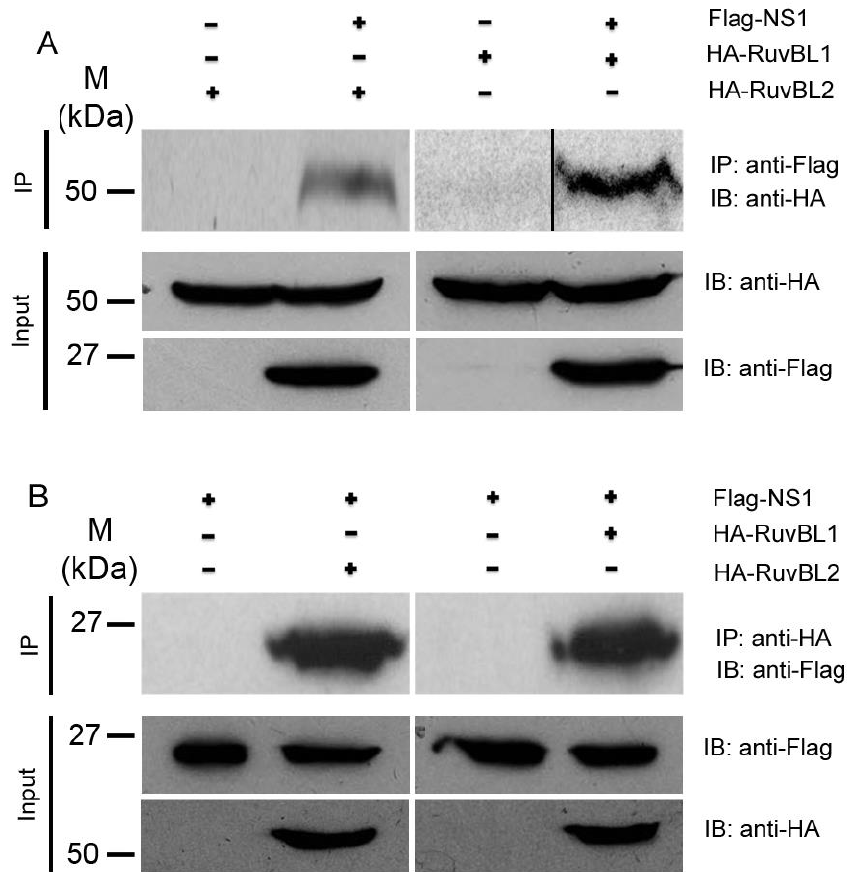
Figure 2. Validation of the interactions between the NS1 and RuvBL1/RuvBL2. ( A ) co-IPs: Cell lysates from the cells expressing Flag-NS1 and HA-RuvBL1/HA-RuvBL2, or the cells expressing Flag alone and HA-RuvBL1/HA-RuvBL2 (control), were immunoprecipitated with anti-Flag M2 resin, and the immunoprecipitated proteins were probed with an anti-HA antibody in Western blotting. ( B ) Reciprocal co-IPs, cell lysates from the cells expressing Flag-NS1 and HA-RuvBL1/HA-RuvBL2, or the cells expressing HA alone and Flag-NS1 (control), were precipitated with an immobilized anti-HA antibody, and the immunoprecipitated proteins were probed with an anti-Flag antibody in Western blotting. IP: immunoprecipitation; IB: immunoblotting.